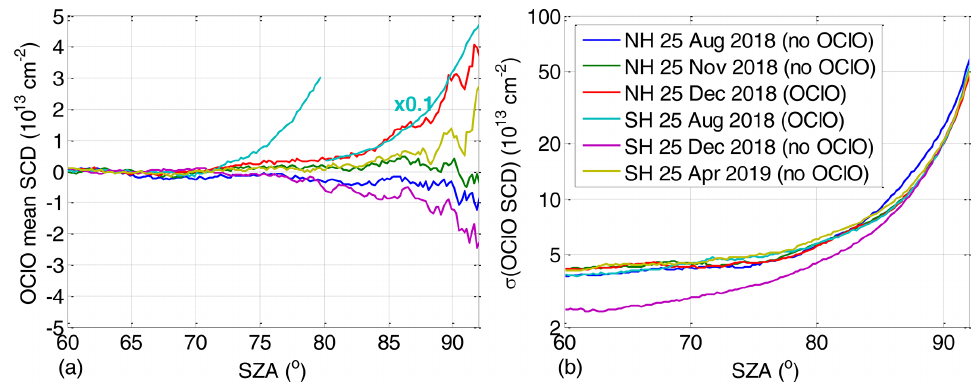
Figure 1. (a) OClO mean SCDs resolved on 0.2 ◦ SZA grid for 3d indicated in the legend on the right in different seasons for each hemisphere. It is also indicated which days are expected to have enhanced OClO. Note that the SCDs as plotted for 25 August 2018 in the SH are multiplied by the factor of 0.1 for SZAs above 80 ◦ . (b) Same but standard deviation of OClO